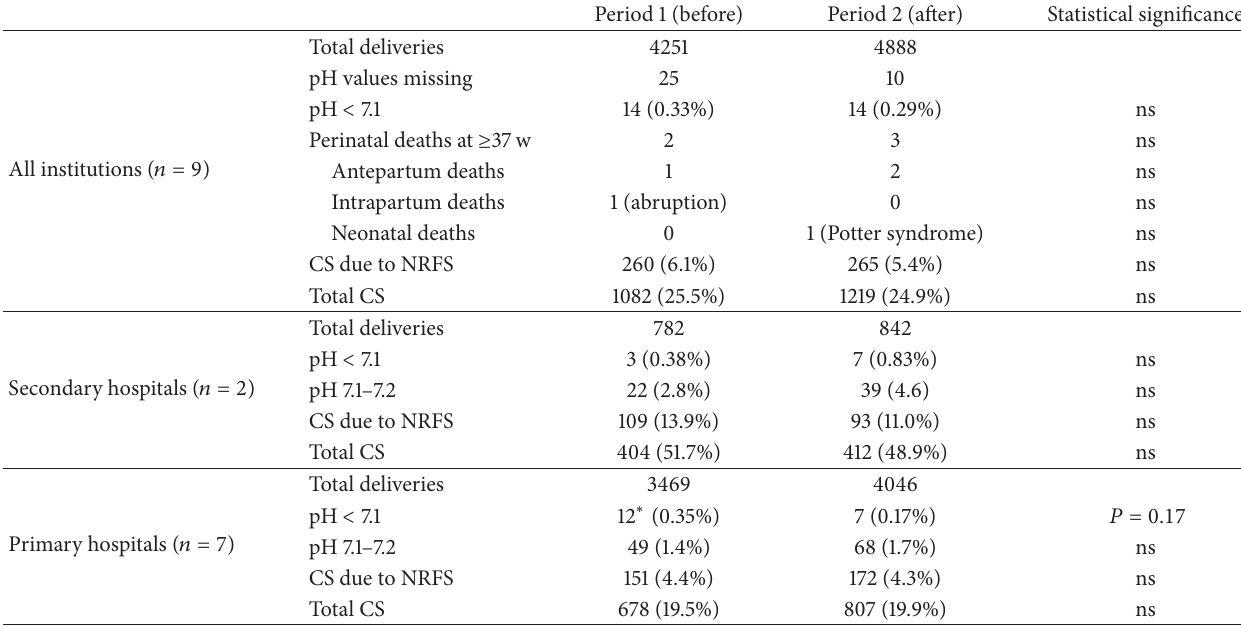
Table 1: The incidence of low pH values, perinatal deaths, and cesarean births before and after the introduction of FHR centralization. Period 1